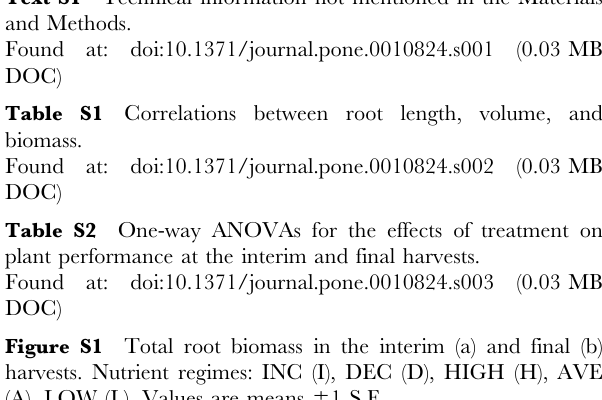
Figure S3 Total plant biomass in the interim (a) and final (b) harvests. Nutrient regimes: INC (I), DEC (D), HIGH (H), AVE (A), LOW (L). Letters indicate significant differences (Tukey), Bars lacking letters do not differ from any other bar. Values are means 6 1 S.E. Found at: doi:10.1371/journal.pone.0010824.s006 (0.43 MB TIF) Figure S4 Root allocation in the interim (a) and final (b) harvests. Nutrient regimes: INC (I), DEC (D), HIGH (H), AVE (A), LOW (L). Values are means 6 1 S.E. Found at: doi:10.1371/journal.pone.0010824.s007 (0.43 MB TIF) Figure S5 Reproductive mass in the final harvest. Nutrient regimes: INC (I), DEC (D), HIGH (H), AVE (A), LOW (L). Values are means 6 1 S.E. Found at: doi:10.1371/journal.pone.0010824.s008 (0.38 MB